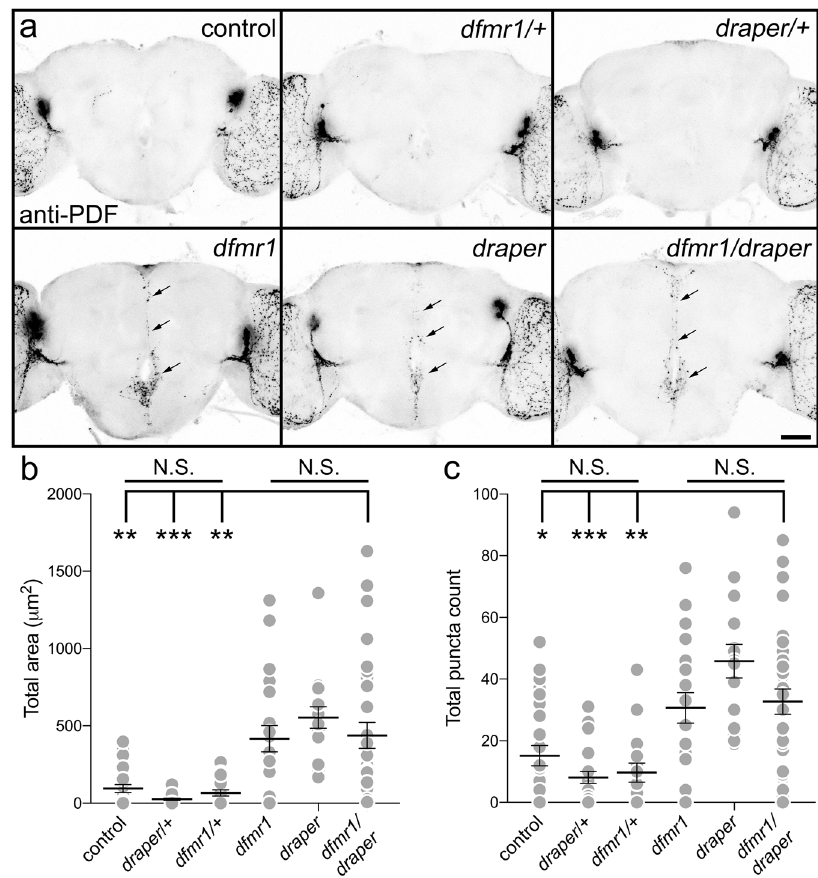
Fig. 5 FMRP and Draper genetically interact to drive central PDF-Tri neuron elimination. a Whole brains (5 DPE) labeled with anti-PDF in all controls (top row); genetic background control ( w 1118 ), dfmr1 null heterozygote control ( w 1118 ; dfmr1 50M / + ), and draper null heterozygote control ( w 1118 ; draper Δ 5 / + ). All three controls lack the central brain PDF-Tri neurons. The bottom row shows the three experimental genetic conditions; the dfmr1 homozygous null mutant ( w 1118 ; dfmr1 50M ), the draper homozygous null mutant ( w 1118 ; draper Δ 5 ), and the dfmr1/draper null trans-heterozygote ( w 1118 ; dfmr1 50M / draper Δ 5 ). All three genotypes exhibit persistent PDF-Tri neurons (arrows). Scale bar: 50 μ m. Images are representative of three independent experiments. b Quanti fi cation of anti-PDF area for the central PDF-Tri neurons in all six genotypes. Kruskal – Wallis followed by Dunn ’ s multiple comparison test, p > 0.9999, 94.75 ± 25.94 n = 25 control, 25.60 ± 7.212 n = 19 draper Δ 5 / + , 66.16 ± 19.78 n = 19 dfmr1 50M / + , p = 0.0068 94.75 ± 25.94 n = 25 control vs. 417.2 ± 84.86 n = 20 dfmr1 , p < 0.0001 94.75 ± 25.94 n = 25 control vs. 553.2 ± 69.81 n = 16 draper , p = 0.0020, 94.75 ± 25.94 n = 25 control, 438 ± 69.81 n = 31 dfmr1/draper . c Quanti fi cation of anti-PDF puncta number for the central PDF-Tri neurons in all six genotypes. Kruskal – Wallis followed by Dunn ’ s multiple comparison test, p > 0.9999, 15.15 ± 3.3 n = 27 control, 8.091 ± 1.931 n = 22 draper Δ 5/ + , 9.667 ± 3.067 n = 18 dfmr1 50M / + , p = 0.176 15.15 ± 3.3 n = 27 control vs. 30.65 ± 4.944 n = 18 dfmr1 , p = 0.0003 15.15 ± 3.3 n = 27 control vs. 45.81 ± 5.443 n = 16 draper , p = 0.0155, 15.15 ± 3.3 n = 27 control, 32.68 ± 4.069 n = 31 dfmr1/draper . The scatter plot graphs show mean ± SEM. Sample size is n = number of animals. Signi fi cance shown for p > 0.05 (not signi fi cant, N.S.), p < 0.05 (*), p < 0.01 (**), and p < 0.001 (***). Source data for this fi gure are provided in Source Data fi